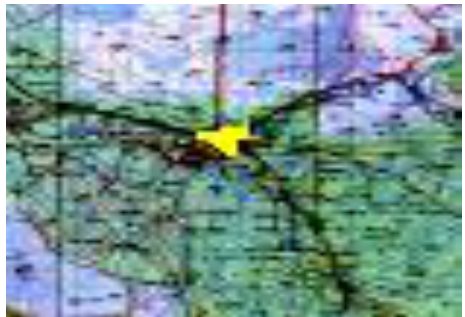
Fig.14: Illustrated the network for map with 1:250,000 scale.